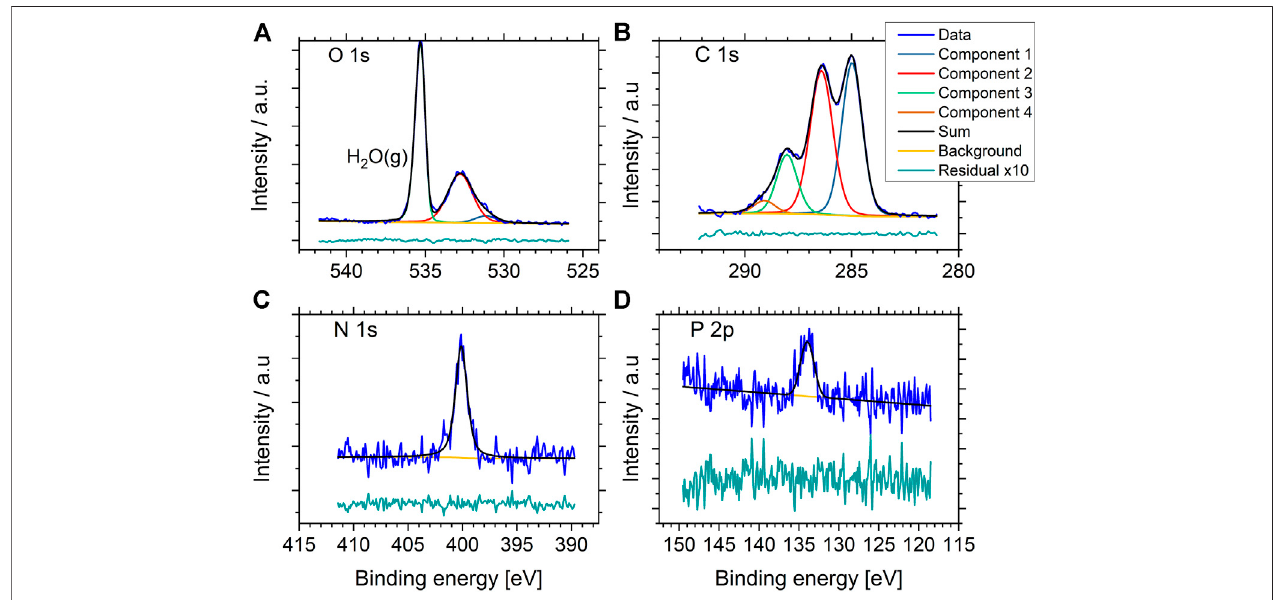
FIGURE 3 | Representative high resolution O1s, C1s, N1s, and P2p NAP- XP spectra of P. fl uorescens held in 15 mbar water vapor atmosphere during analysis. The green tracks display the residuals after subtracting the sum of the component peaks from the experimental spectrum (blue), multiplied by 10 for better visibility.